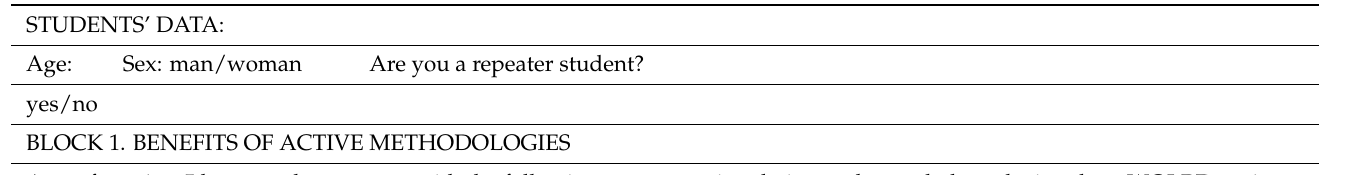
Table A1. Self-made questionnaire for students based on D á vila et al. (2017), (Google forms application)